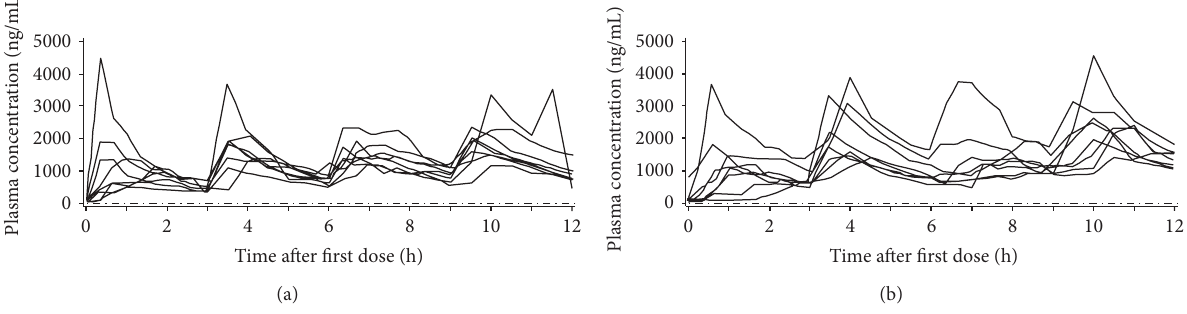
Figure 3: L-dopa plasma concentrations for patients in Cohort 3 (dose administration every 3 hours) receiving V1512 solution plus entacapone 200 mg (a) or L-dopa/carbidopa 100/25mg standard-release tablets plus entacapone 200 mg (b). All patients with data available for the pharmacokinetic analyses were included; patients with significant violations that may have invalidated or biased the results of the pharmacokinetic evaluations were excluded. – ⋅ – ⋅ – ⋅ = lower limit of quantification